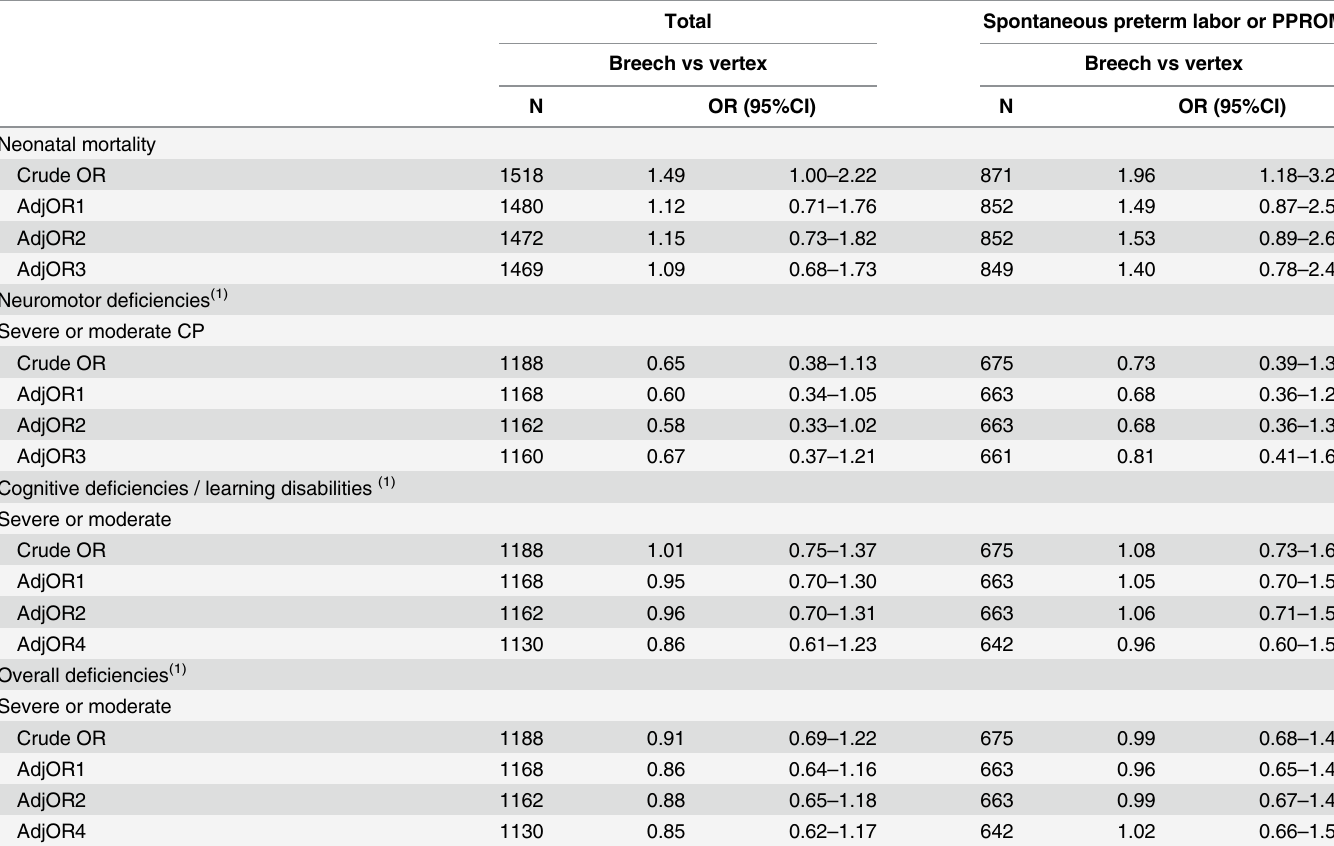
Table 5. Neonatal mortality and long term neurodevelopmental outcome according to fetal presentation, multivariate